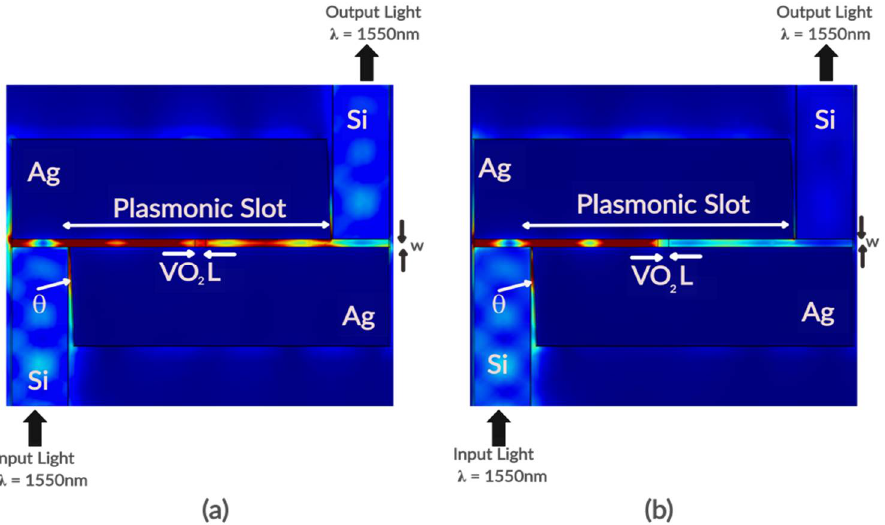
Figure 2. Planar cross-section view of device showing surface plot of electric field norm in ( a ) Left Semiconductor phase of VO 2 (Device OFF) and ( b ) Right Metallic phase (Device ON) of VO 2 .